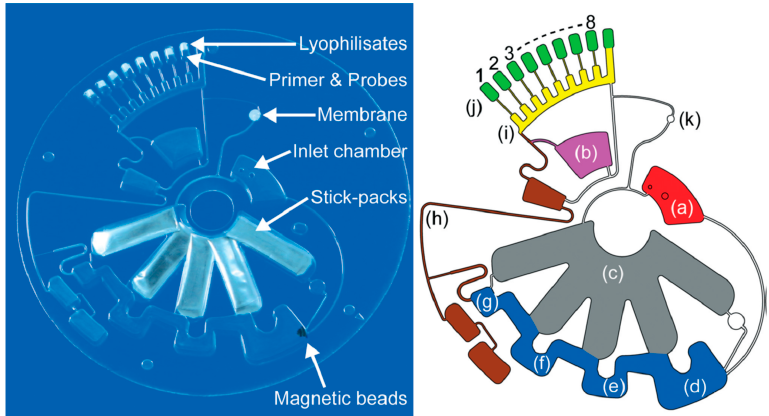
Figure 12. ab-on-a-disk platform for the automatic sequence of reactions for RT-qPCR with complete reagent prestorage. Photograph ( left ) and a CAD drawing ( right ) of the Lab-on- a-disk with the inlet chamber (a) stick-packs for reagents pre-storage (c) connected to the Teflon coated nucleic acid extraction structure (d–g) consisting of the lysis and binding chamber (d) wherein the magnetic beads are prestored, the washing chamber 1 (e) and 2 (f) and the eluation chamber (g). The microfluidic channels and pneumatic chambers in the area of (h) allow fluids handling to the aliquoting chambers (i) and to the reaction chambers (j) where primers, fluorescence probes and RT-PCR lyophilisates are prestored. Chamber (b) can be used. for loading a liquid RT-PCR mastermix instead of lyophilisates. reproduced with permission from [124].